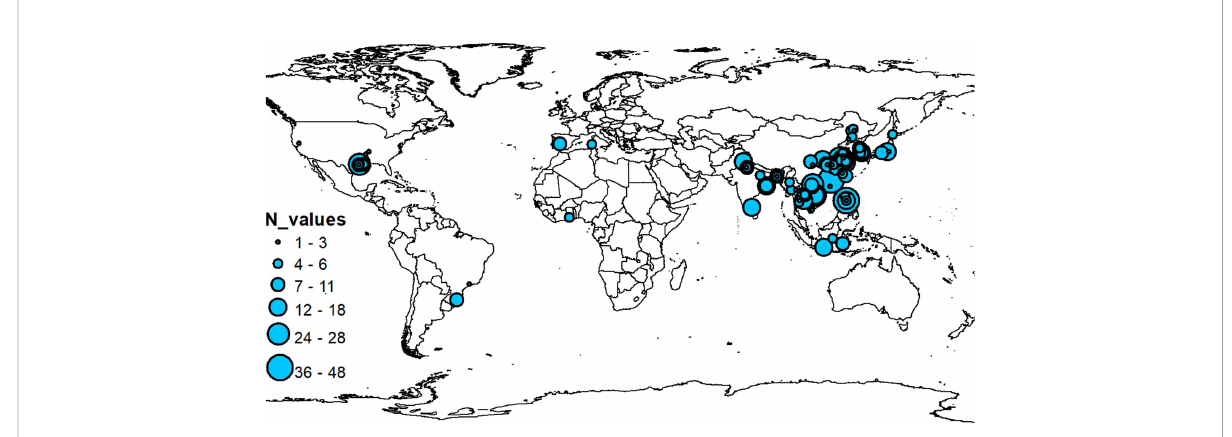
FIGURE 1 Site experiment locations of collected data from peer-reviews used for evaluating the existing empirical CH 4 models with N values representing number of